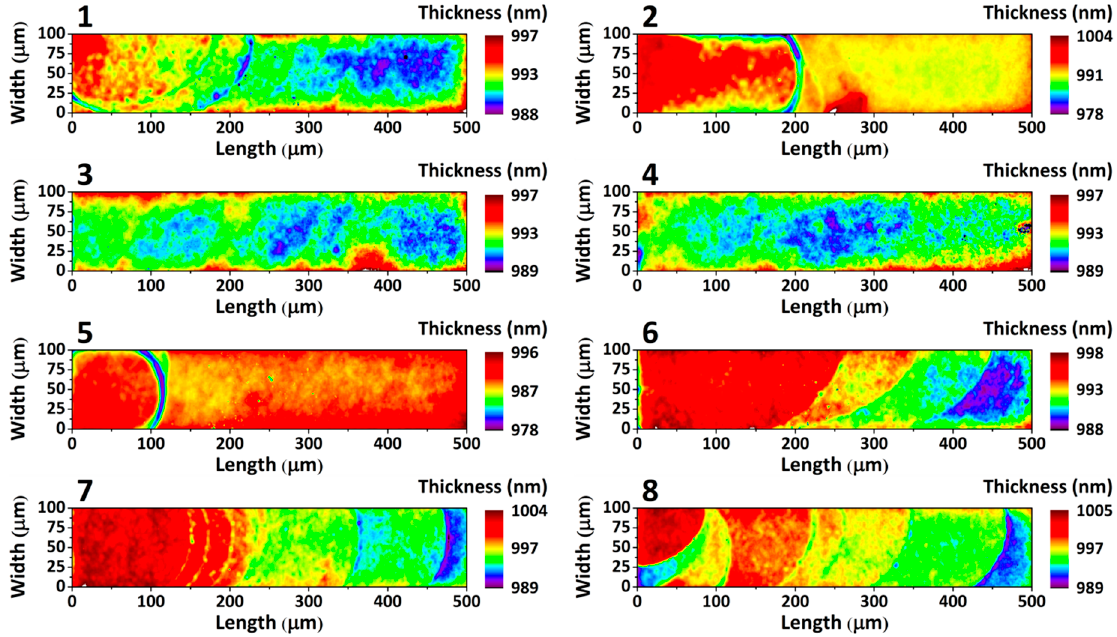
Figure 4. Thickness map of eight silicon cantilevers from the same chip array; the color bars represent the cantilever thickness along the microstructure in nanometers (nm).